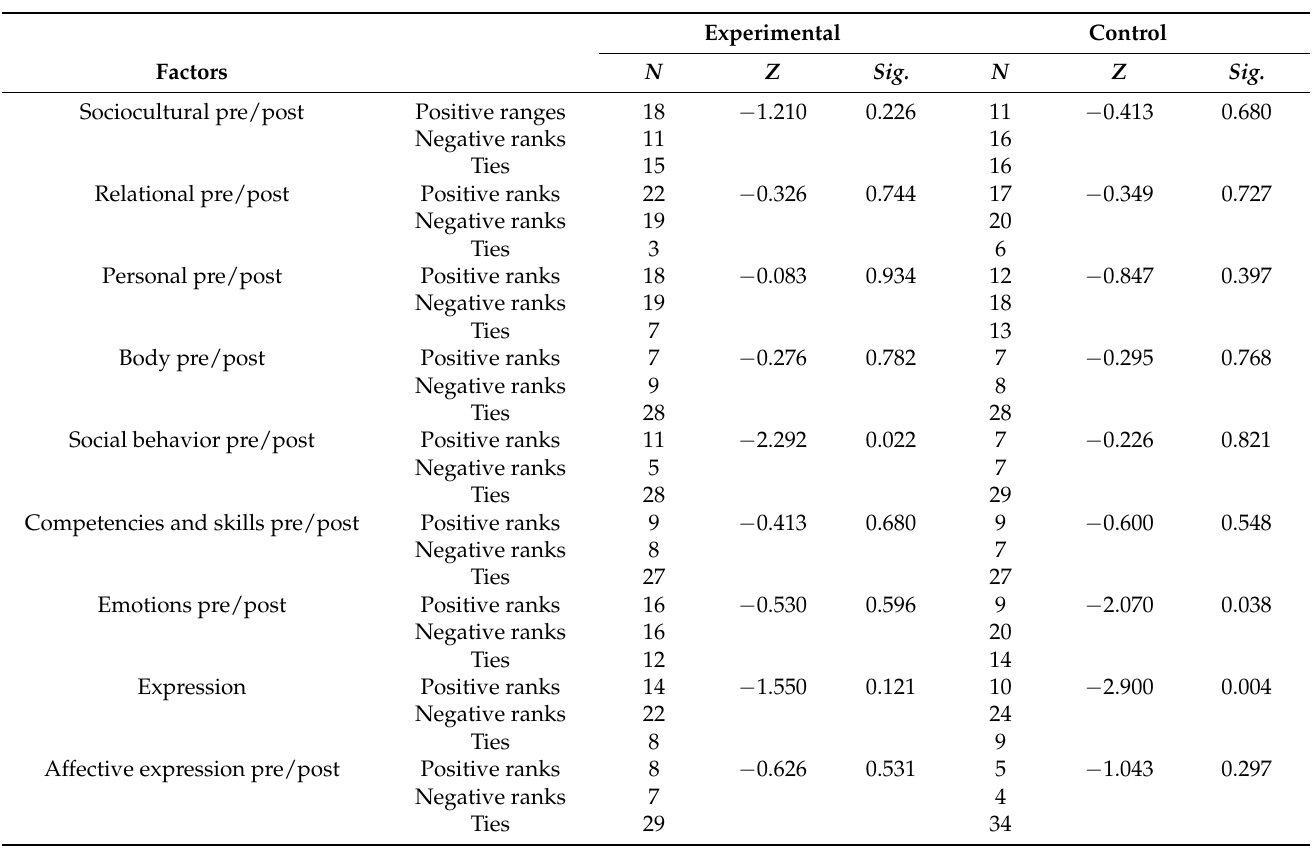
Table 4. Effect of group-sport-based interventions without gender bias for the experimental and control groups on gender attitudes in the experimental and control